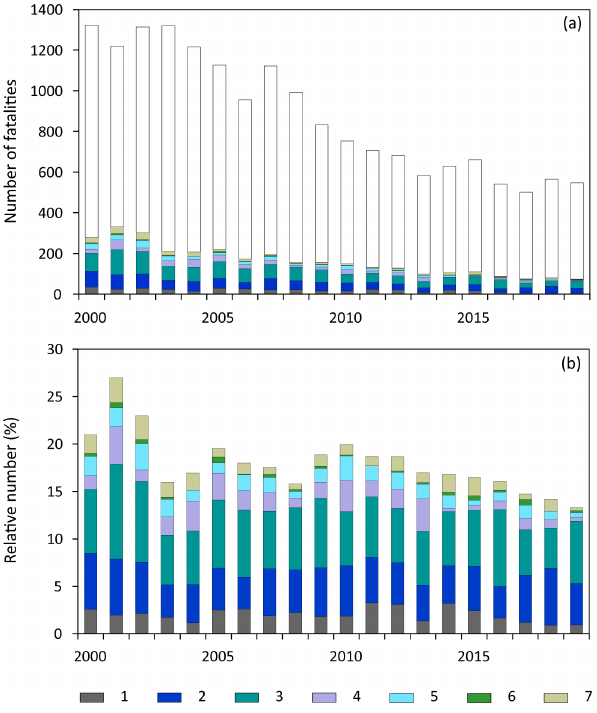
Figure 13. Fluctuation in (a) the annual number of all vehicle acci- dent fatalities including those during inclement weather conditions and in (b) their relative percentage of the relevant annual number of vehicle accident fatalities in the Czech Republic during the 2000– 2019 period (1 – fog, 2 – onset of rain and light rain, 3 – rain, 4 – snowfall, 5 – rime and glaze ice, 6 – gusty wind, 7 – other inclement weather patterns). Data according to police database of vehicle ac-